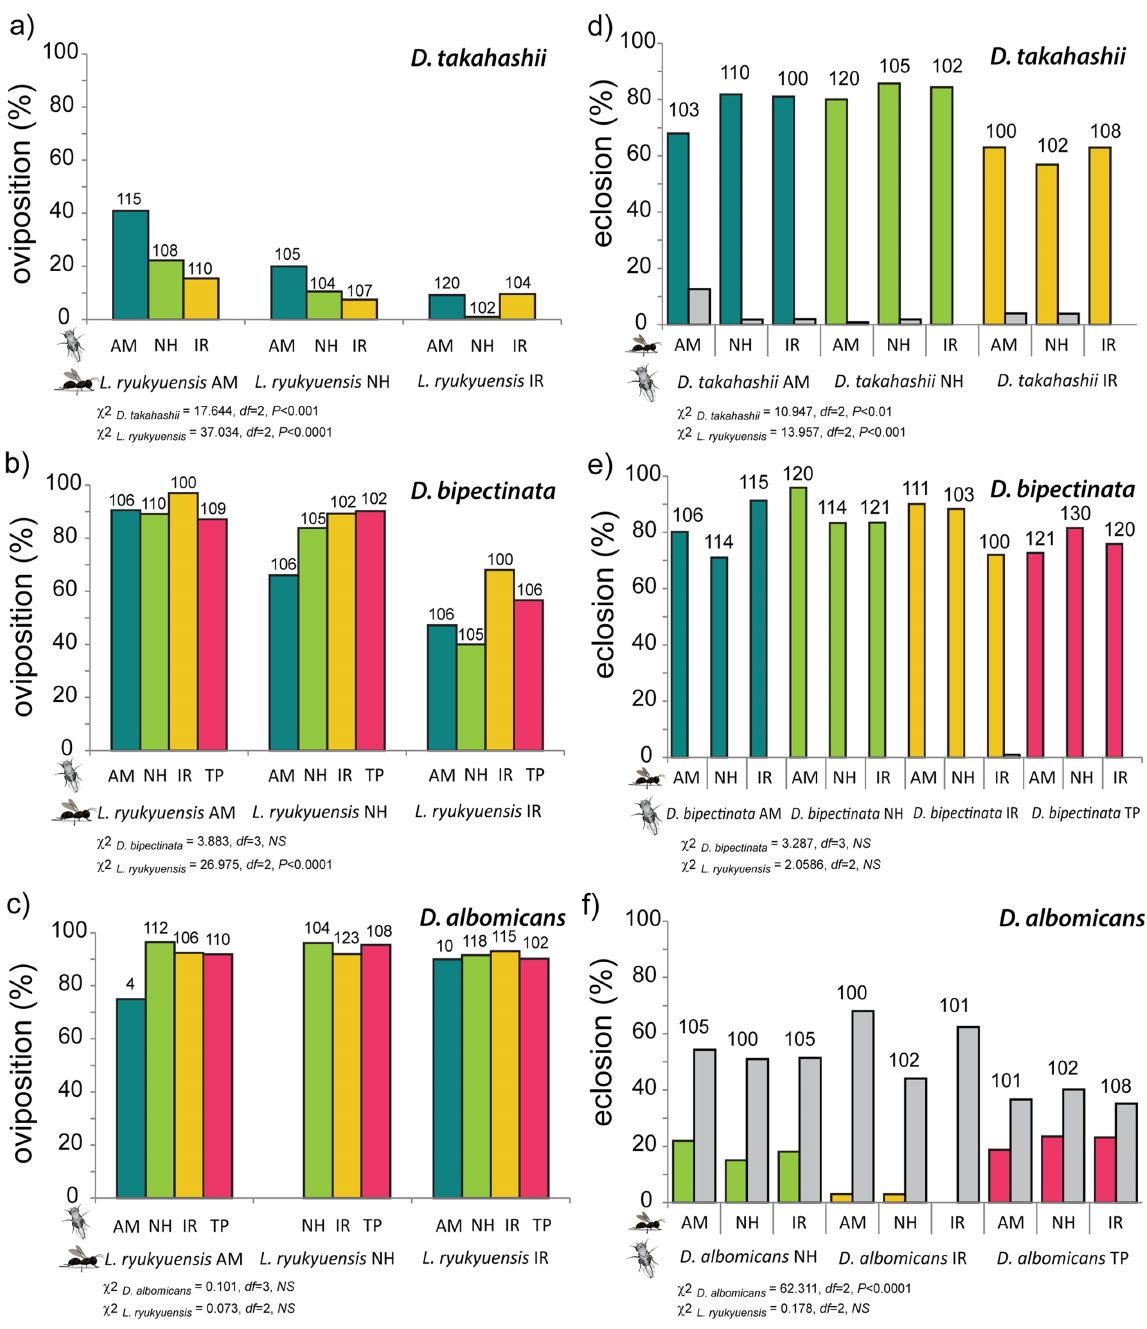
Fig 5. Host acceptance and host suitability. Left column shows the host acceptance of AM, NH, and IR strains of L . ryukyuensis for each strain of D . takahashii , D . bipectinata , and D . albomicans . Right column shows the emergence of flies (in colour) and wasps (gray) in host suitability experiments. Numbers above each bar indicate the number of host larvae tested. Colours represent different fly populations: AM (blue), NH (green), IR (yellow), and TP (red). Chi-squared and P values obtained for fly strains as predictor variables, and wasp strains as predictor variables, are given below each graph.